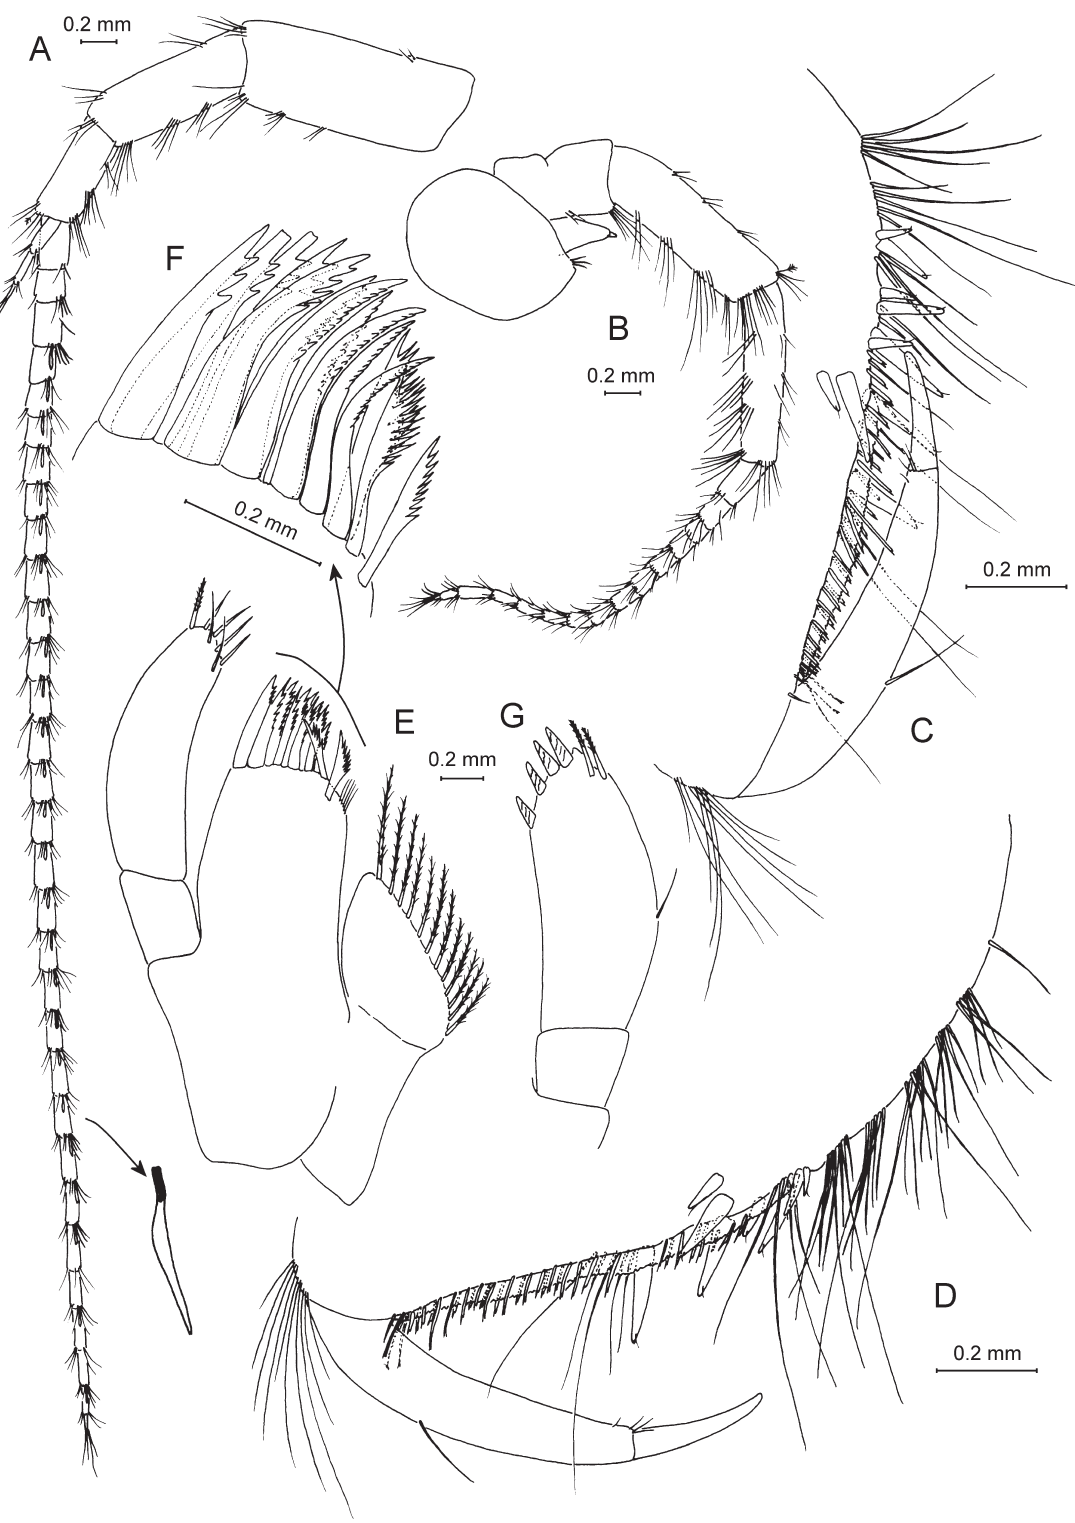
Fig. 5. Anopogammarus birsteini Derzhavin, 1945. ♀, 9.0 mm, X44039/Cr-1645-FEFU. A . Antenna 1. B . Antenna 2. C–D . Palmar margins of gnathopods 1 and 2 propodi. E . Maxilla 1. F . Outer plate of maxilla 1. G . Palp of right maxilla